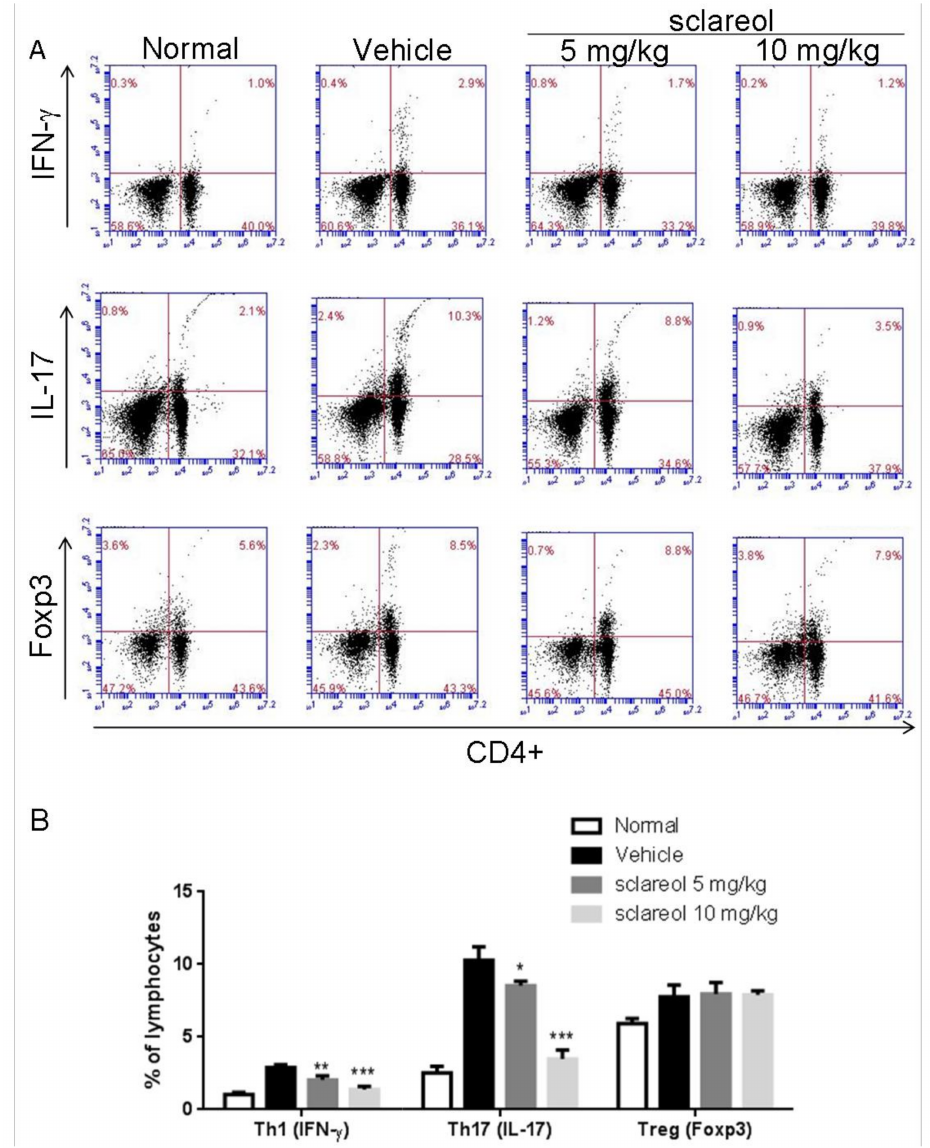
Figure 4. Sclareol reduced Th1 cells (CD4 + IFN- γ + T cells) and Th17 cells (CD4 + IL-17 + T cells) in the inguinal lymph nodes (ILNs). ( A ) Single cell suspensions were collected from ILNs, followed by stimulation with 20 ng/mL phorbol myristate acetate (PMA) and 1 µ g/mL ionomycin in the presence of 10 µ g/mL brefeldin A for 4 h and then stained with anti-CD4, anti-IFN- γ , anti-IL-17A, or anti-Foxp3 Abs and analyzed by flow cytometry. Representative results in each group are shown. ( B ) Cell population results were quantified and represent as the mean ± SD with six mice per group. * p < 0.5, ** p < 0.01 and *** p < 0.001 versus vehicle-treated CIA